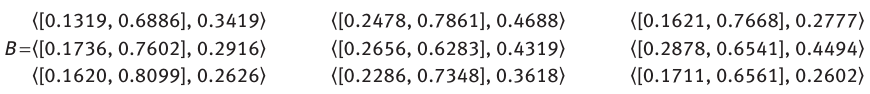
Table 2: The Aggregated CF-Decision Matrix.